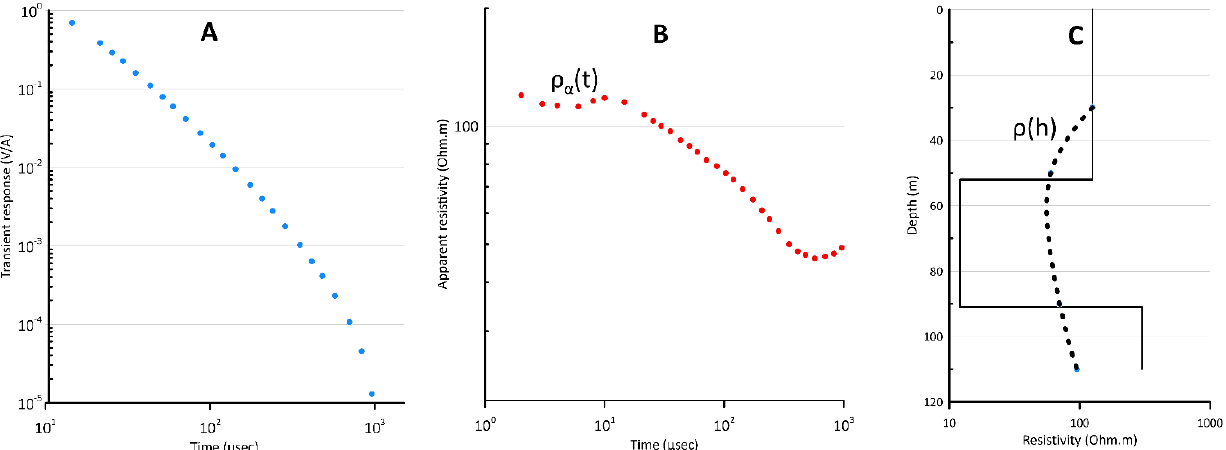
Figure 4. Transient response ( A ), apparent resistivity curve with time (B), and the transformation/inversion of the measured data ( E ( t )/ I ) to the ρ ( h ) dependence ( C ) from TEM station 058A. The blue circles in ( A ) correspond to the observed transient responses with time. The red curve with red circles in ( B ) labeled ρ a ( t ) is the calculated apparent resistivity response by applying the asymptotic formula to the observed transient responses. The last graph ( C ) shows the transformation (dashed black line) and step-wise (layered) inversion (continuous black line) of the acquired data.